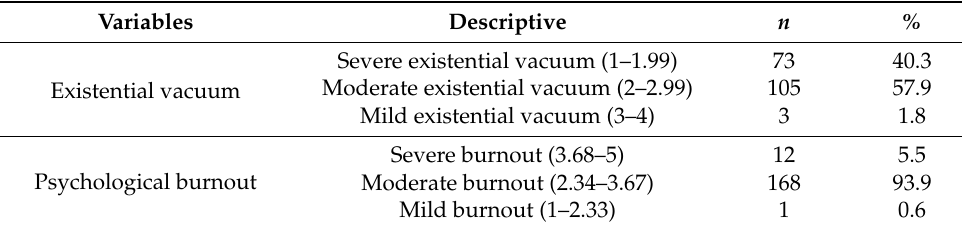
Table 4. Prevalence of existential vacuum and psychological burnout among nurses ( n = 181).